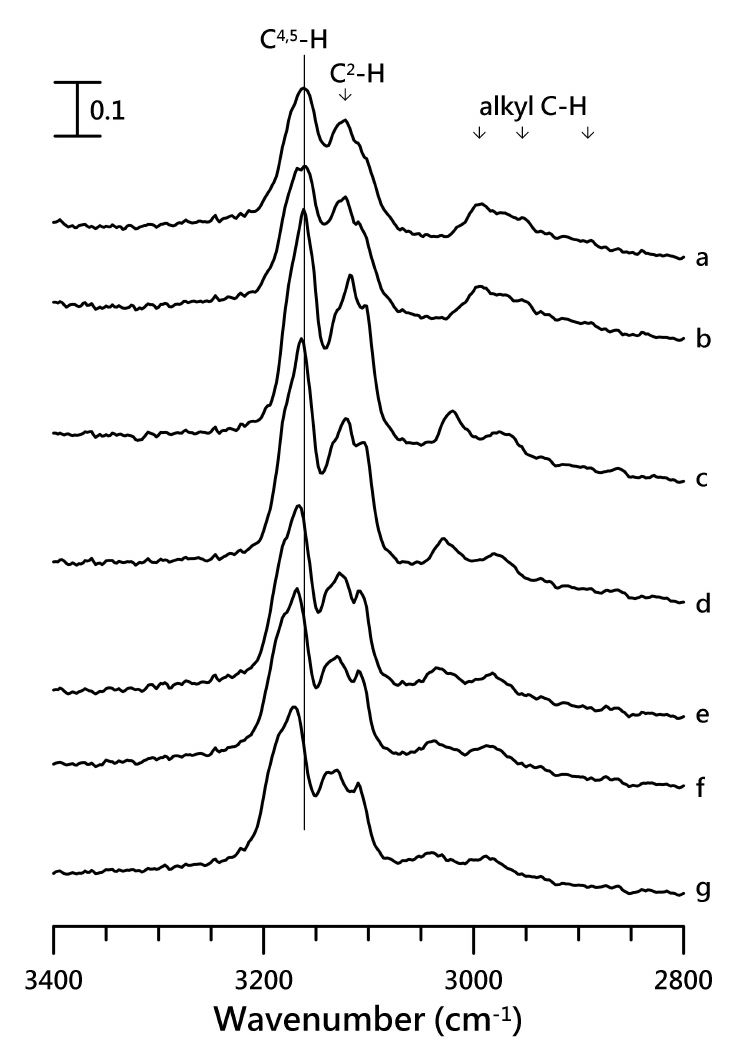
Figure 8. IR spectra of pure [EMIM][NTf 2 ] obtained at ( a ) ambient pressure and ( b ) 0.4, ( c ) 0.7, ( d ) 1.1, ( e ) 1.5, ( f ) 1.8, and ( g ) 2.5